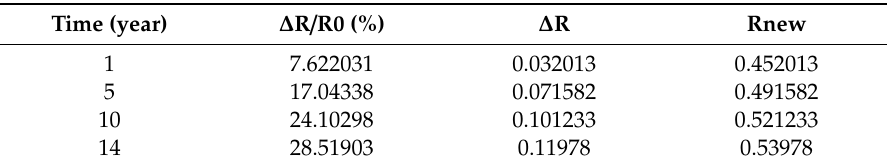
Table 4. Variation of coil’s resistance due to